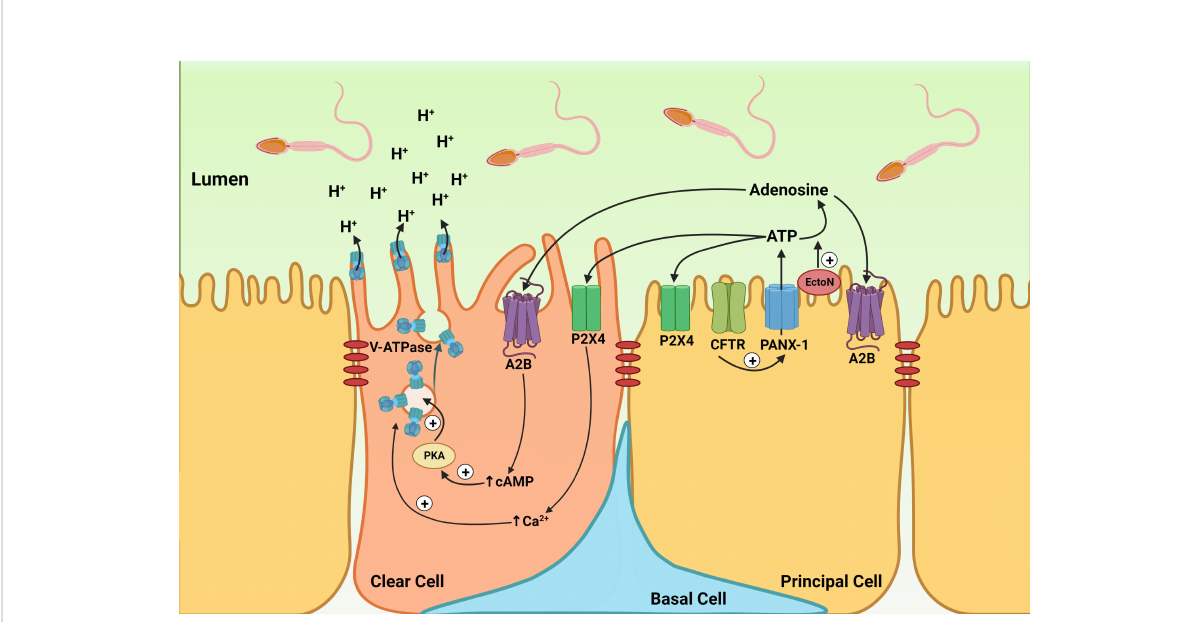
FIGURE 4 Cell-cell crosstalk model of purinergic regulation in the epididymis. Model showing the participation of purinergic regulation in the coordinated interaction between principal cells and clear cells, leading to the establishment of an optimal acidic luminal environment in the epididymis. Located on the apical membrane of PCs, CFTR activation stimulates ATP secretion by the pannexin-1 channel (PANX-1). Extracellular ATP is then hydrolyzed into adenosine by ectonucleotidases (EctoN) that are present on the apical surface of the epithelium. Luminal ATP activates the P2X4 receptor, and adenosine activates the A2B receptors located on the apical membrane of CC. Activation of A2B by adenosine leads to an elevation in intracellular cAMP. Activation of the cAMP/PKA pathway then induces V-ATPase apical membrane accumulation. Intracellular calcium also facilitates V-ATPase membrane accumulation in CCs, following P2X4 receptor activation by luminal ATP. The redistribution of V- ATPase from intracellular vesicles to the apical membrane results in the formation and elongation of V-ATPase-enriched microplicae in CCs, which stimulates proton secretion. The P2X4 and A2B receptors are also located on the apical membrane of PC, and their role in PC function is currently being